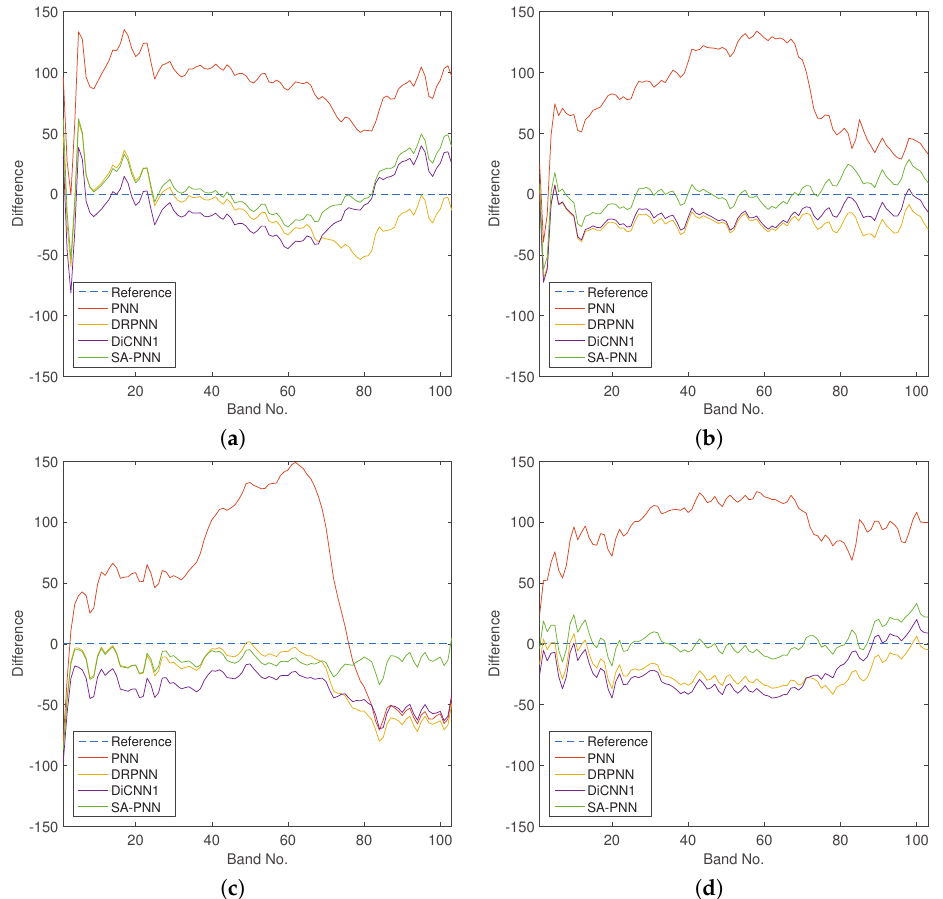
Figure 8. Spectral difference curves between the ground truth and the pansharpening results for the Pavia dataset at randomly selected spatial coordinates: ( a ) (27, 68); ( b ) (125, 68); ( c ) (11, 12); and ( d ) (131, 8), which are marked in Figure 7a with red